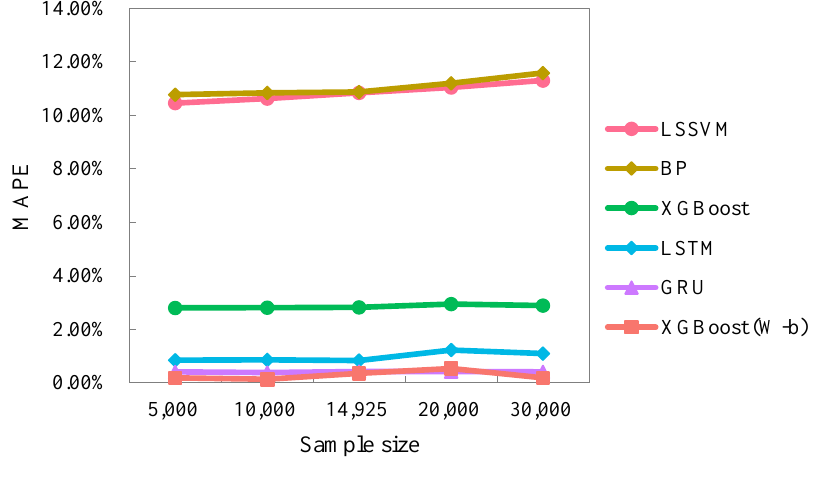
Figure 6. Sensitivity analysis.